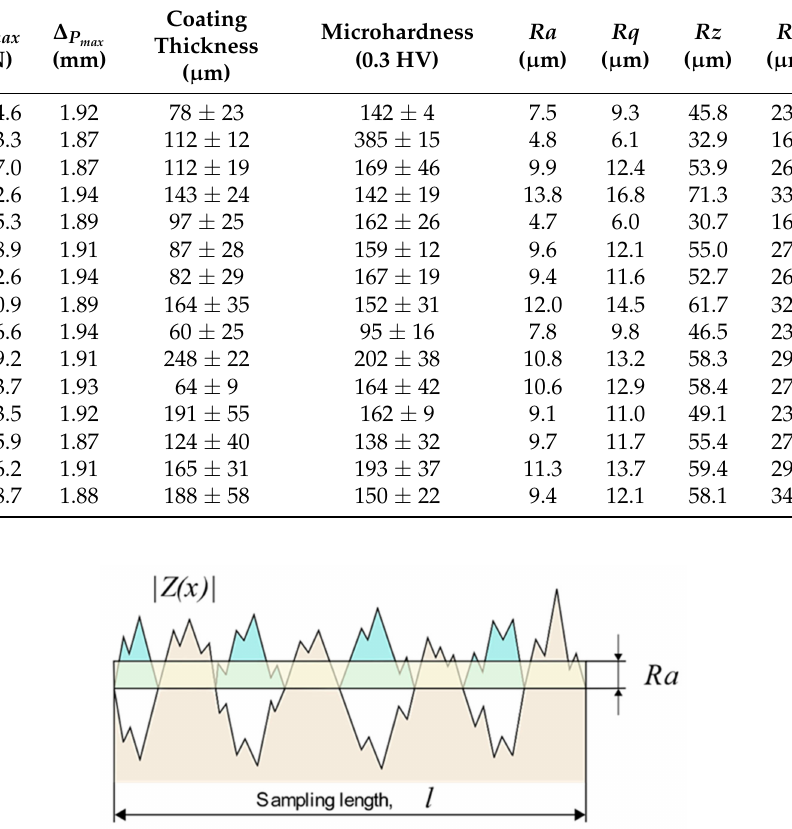
Table 2. Results of Small Punch tests, coating thickness measurement, microhardness and surface roughness values for each APS parameter combination, following the numbering sequence from Table 1.